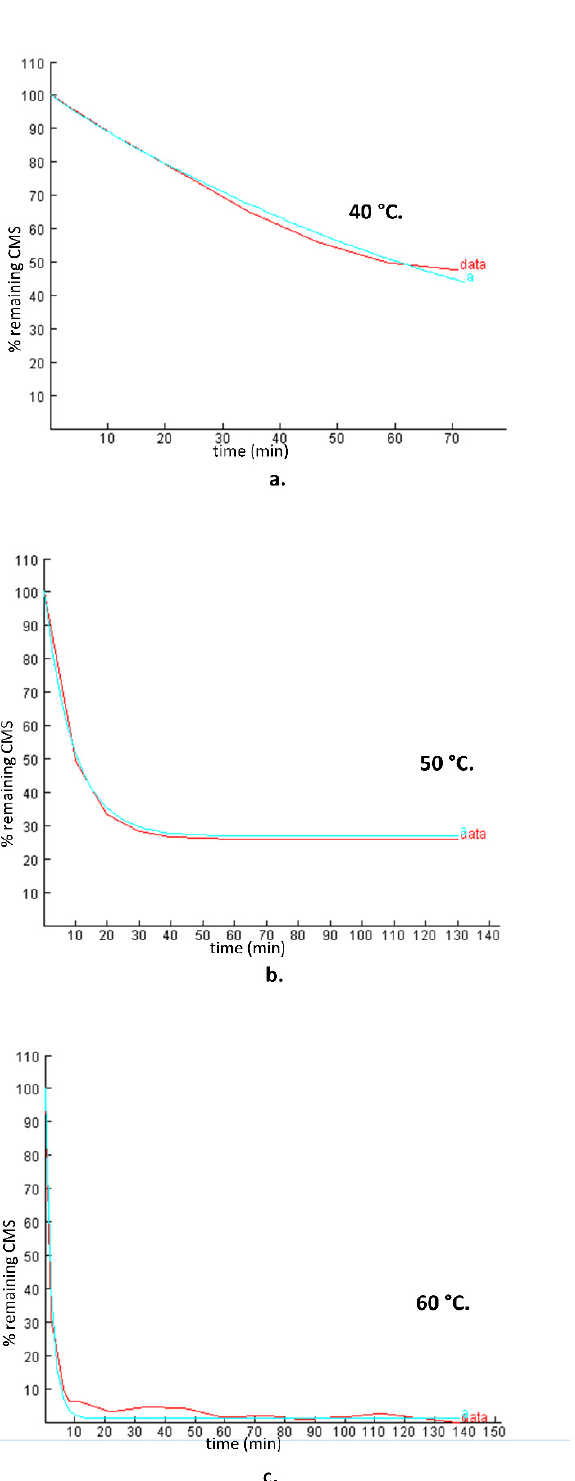
Figure 3. Experimental plots (% remaining CMS versus time) of the CMS degradation in the presence of 0.5 M sulfuric acid (data) and the theoretical models ( a ) simulated by Tenua—the kinetics simulator for Java 2.0—at temperatures of ( a ) 40 ◦ C, ( b ) 50 ◦ C, and ( c ) 60 ◦ C with rate constants of 0.0146 min − 1 , 0.0709 min − 1 , and 0.4485 min − 1 , respectively. The red line represents the experimental data, whereas the blue line represents the theoretical